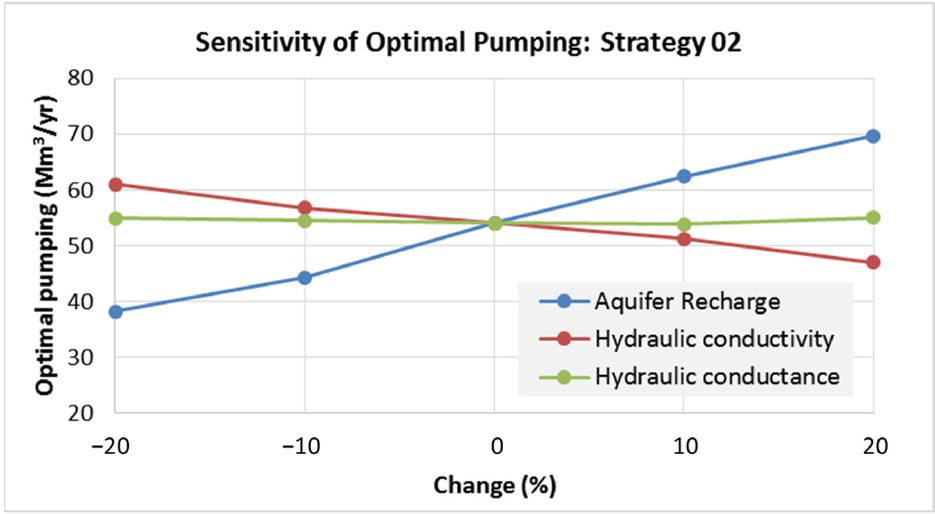
Figure 26. Sensitivity of optimal pumping due to uncertain parameters for strategy 02.